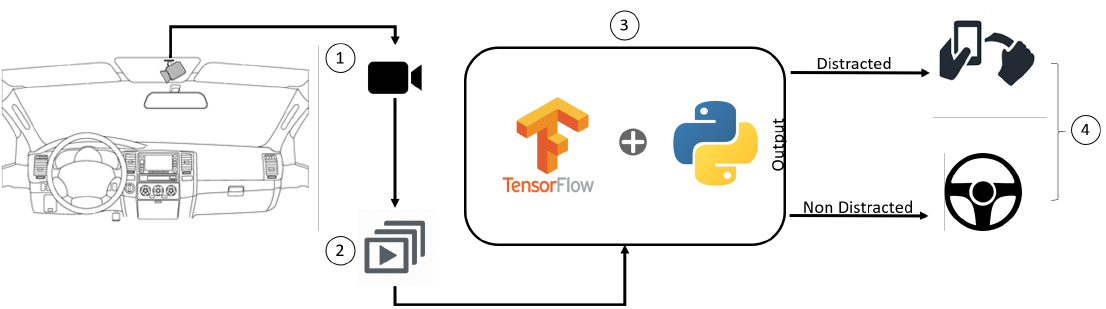
Figure 1. Flowchart of the methodology proposed.